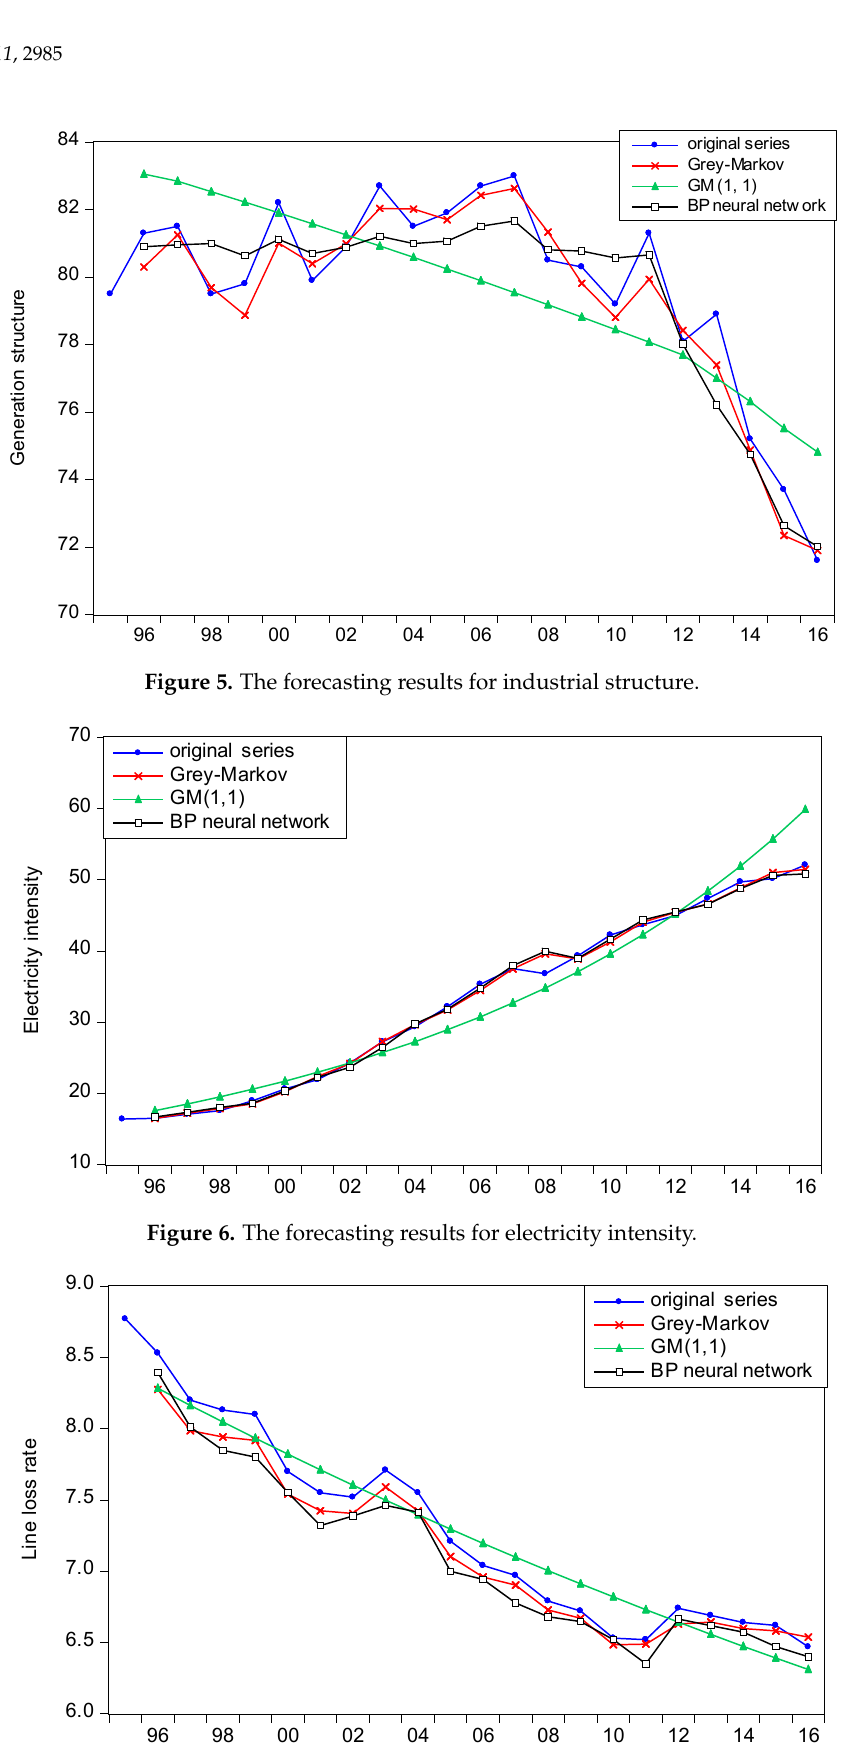
Figure 8. The forecasting results for urbanization level. 4.3.2. Forecasting CO 2 Emissions in the Power Generation Sector After predicting driving factors, this study forecasts CO 2 emissions with the help of the PLS- Grey-Markov model from 1995 to 2016. The results are shown in Figure 9. By comparing predicted and actual values, it can be seen that CO 2 emissions can be well fitted by the PLS-Grey-Markov model. In summary, it is reasonable to conclude the PLS-Grey-Markov model is sufficiently accurate.